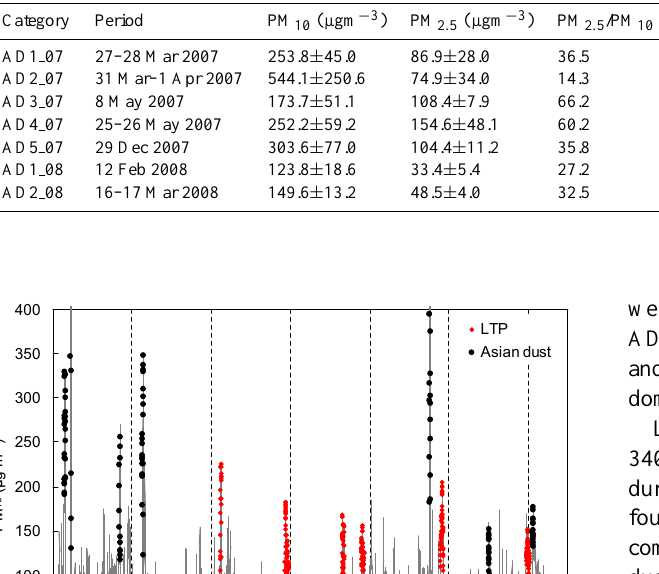
Table 4. Summary of aerosol physical and optical properties measured during different Asian dust periods. Category Period